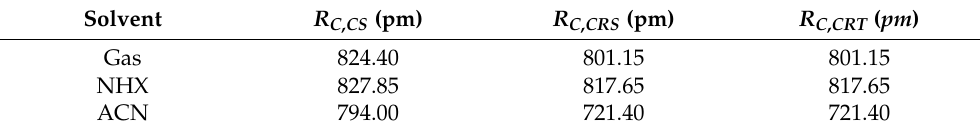
Table 8. The Gibbs free energy change for charge separation, the solvent (   ) and internal reorgan- ization energies (  , ) , as well as the solvent properties (  and   ). The internal reorganization ener- gies calculated using the four-point method with the TZ2P basis and the CAMY-B3LYP functional. CRS = charge recombination to the singlet ground state, CRT = charge recombination to the triplet state, CS = charge separation.